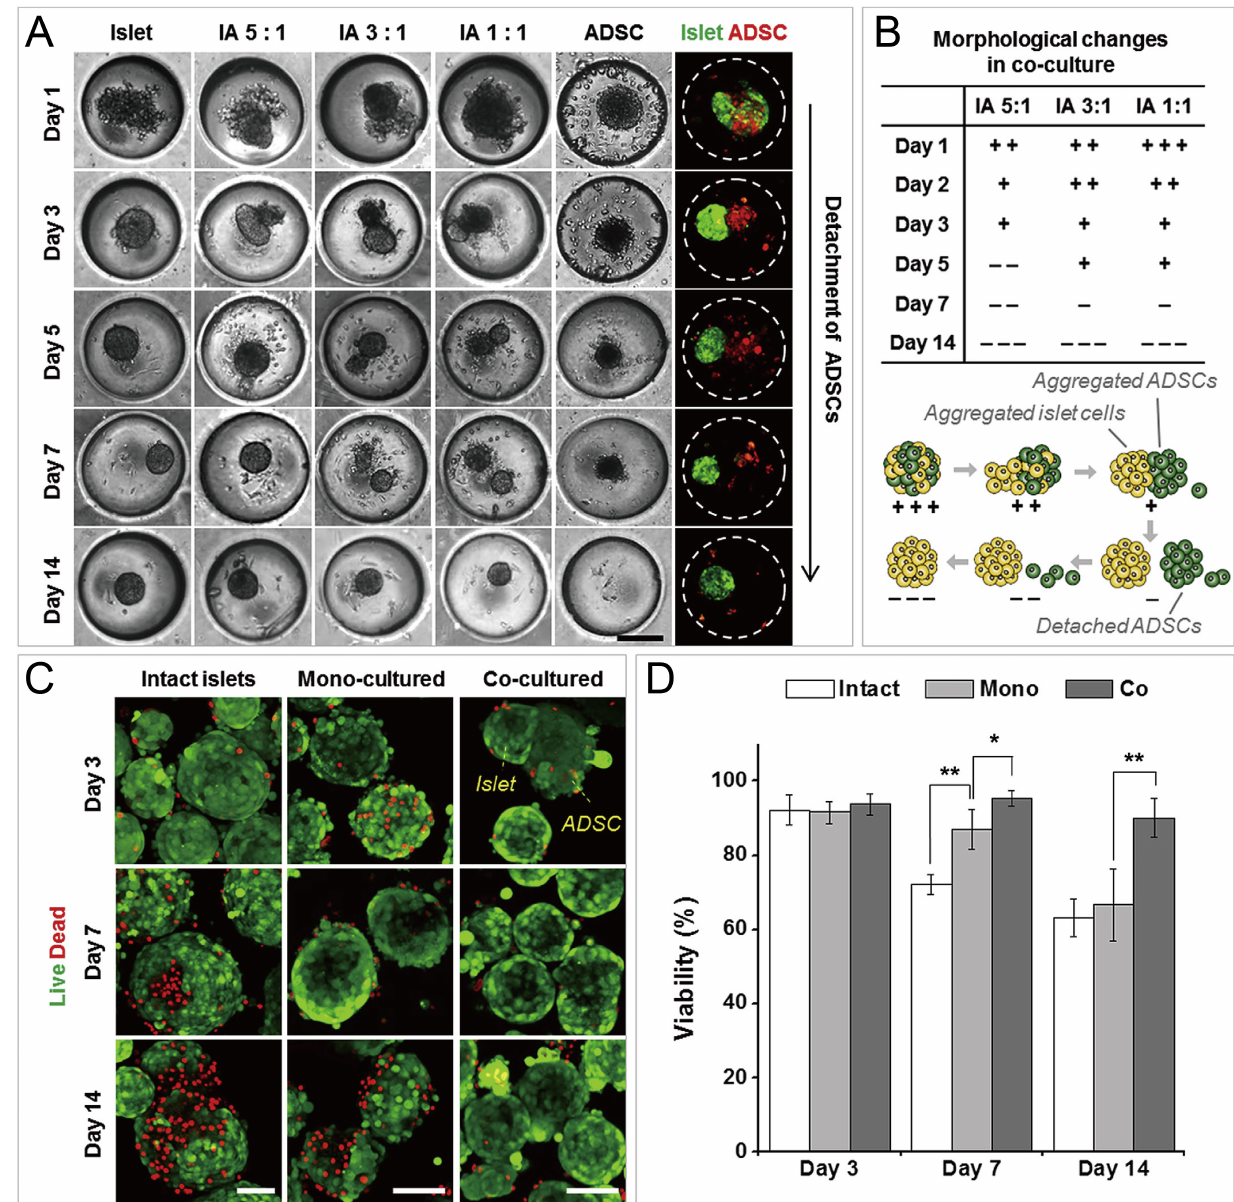
Figure 18. Formation of functional islet spheroids by co-culturing islet cells and ADSCs [96]. ( A ) Bright-field and fluorescent pictures of cell aggregates by mono-culture and co-culture of islet cells and ADSCs. Scale bar: 200 µm. ( B ) Morphology change of co-cultures of islet cells and ADSCs (upper) which is indicated by ’+’ and ’ − ’, and the schematic of the detachment of ADSCs from cell aggregates of islet cells and ADSCs (lower). ( C ) Intact islets and spheroids formed by mono-culture and co-culture, which were stained by live/dead assay. Scale bars: 100 µm. ( D ) Comparison of cell viability of intact islets and spheroids by mono-culture and co-culture. * p < 0.01, ** p < 0.001. Reprinted (adapted) from [96]. Copyright (2014) with permission from